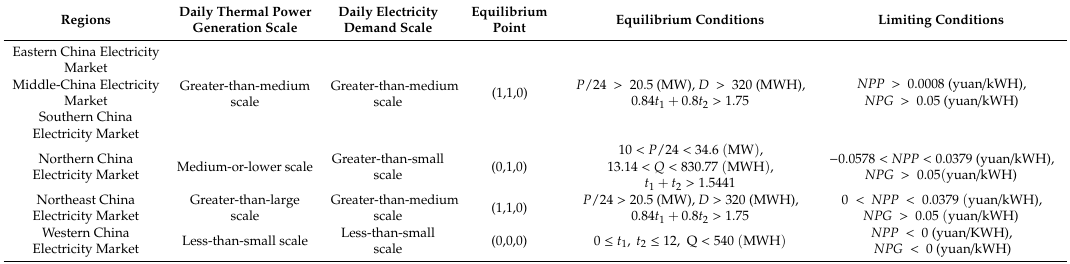
Table 10. Regional equilibrium based on the findings of influence on energy